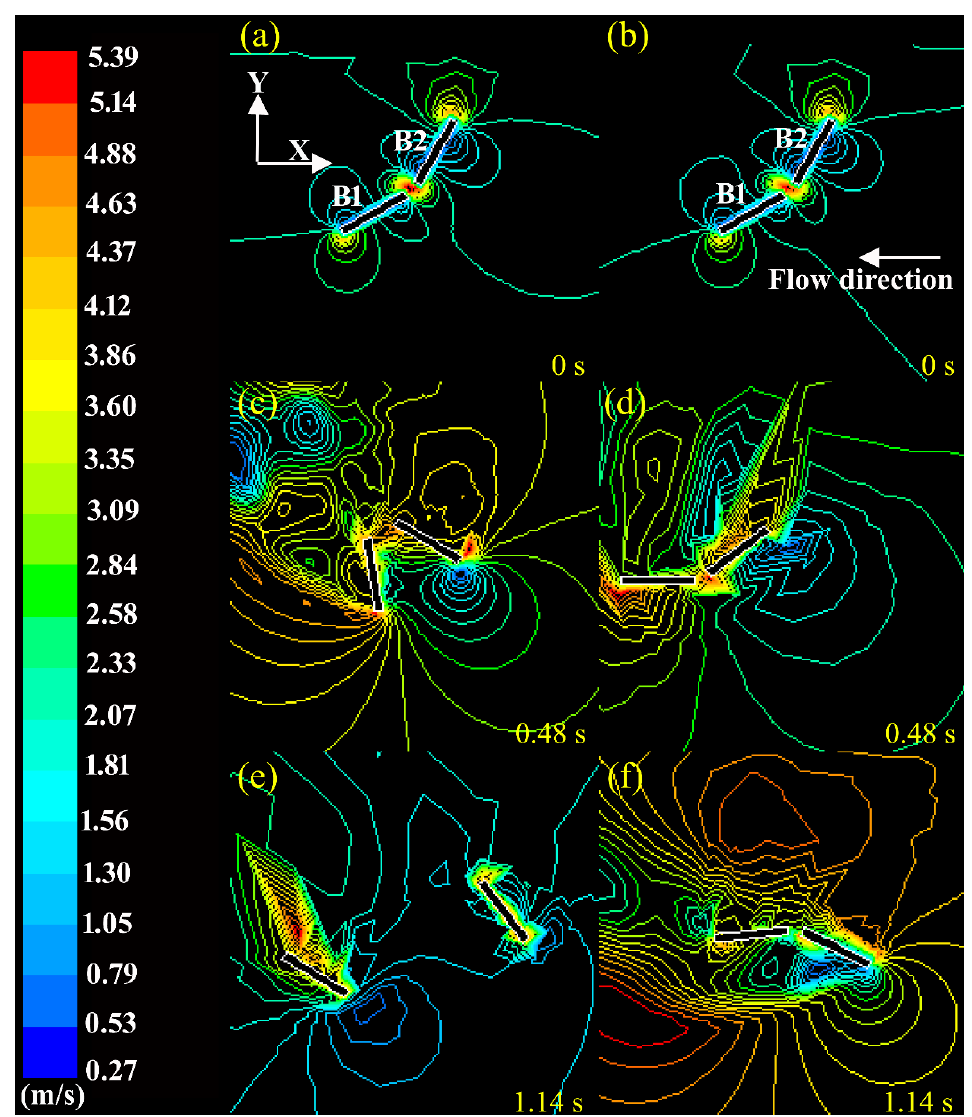
Figure 4. Contours of the velocity of the ( a , c , e ) unconstrained and ( b , d , f ) constrained mechanisms at different simulation times.